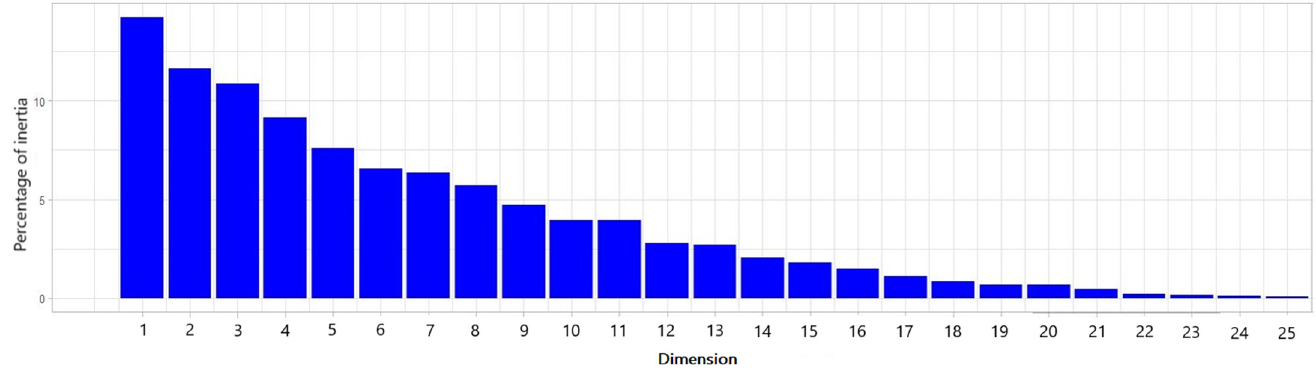
Figure 6. MCA total inertia decomposition.